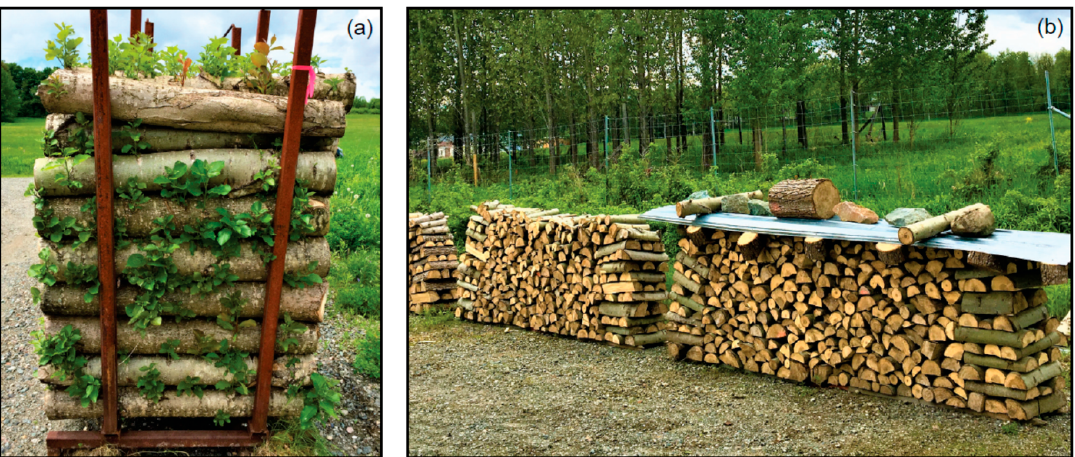
Figure 7. ( a ) On 7 June 2018, unsplit hybrid poplar logs had abundant sprouts, which remained alive until August on the larger diameter logs; and ( b ) on 4 June 2019, no sprouting was observed on short split logs that were processed on 22 May